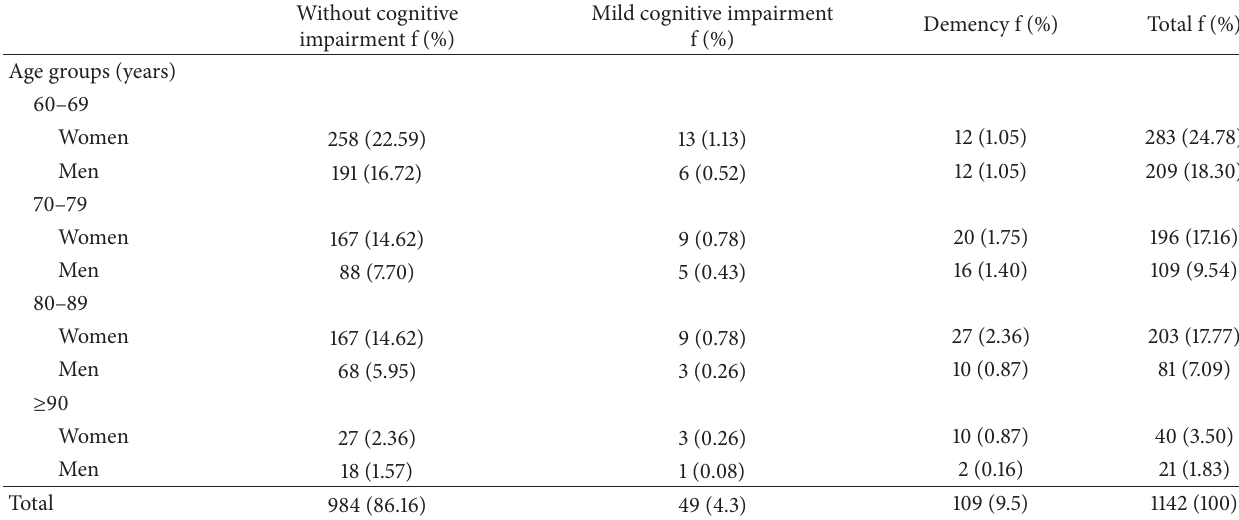
Table 1: Mental status of participants according to age and sex of f participants included in this study ( 𝑛 = 1142 older